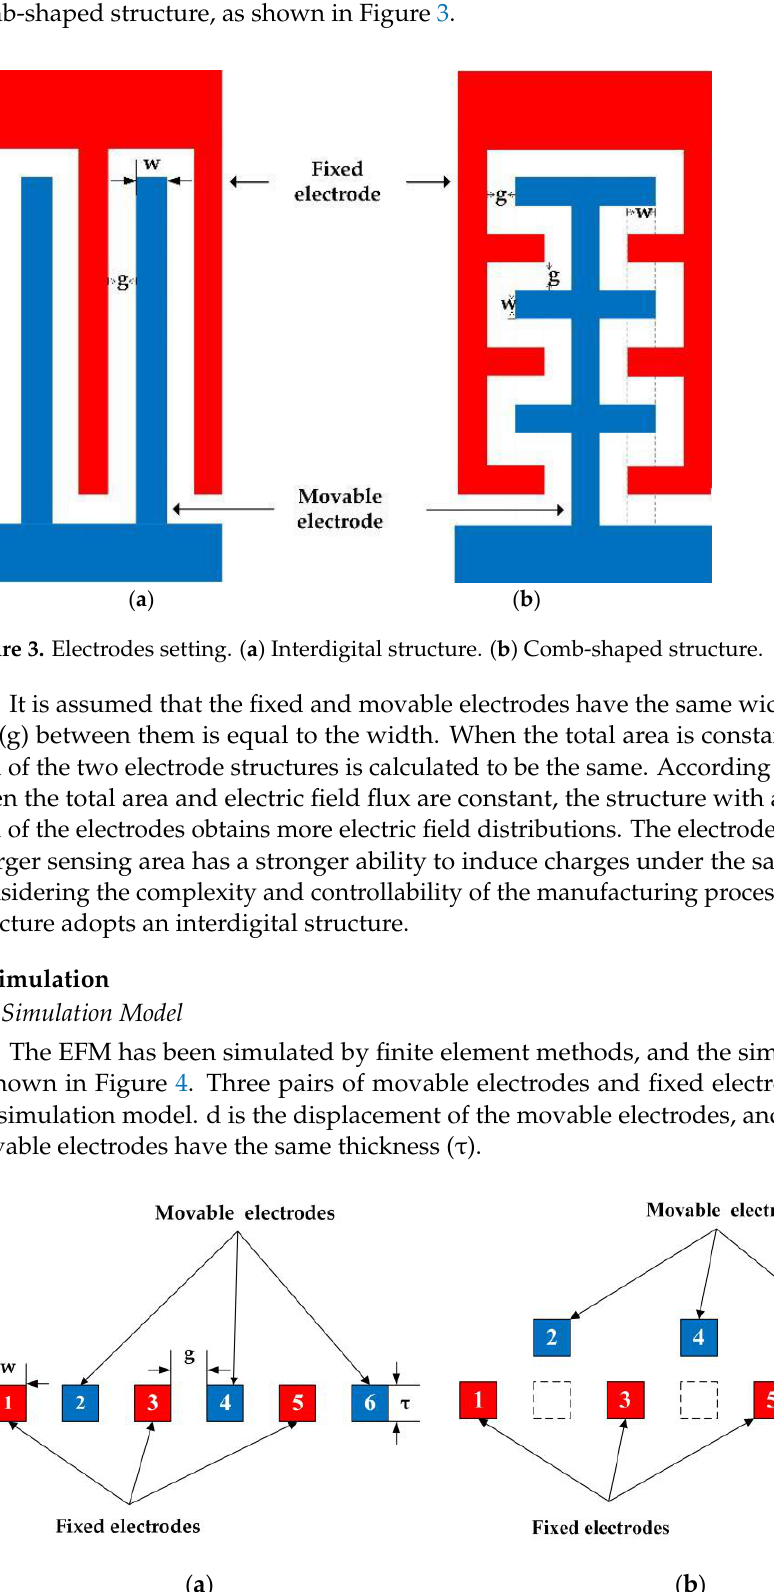
Figure 2. Working principle of the EFM.